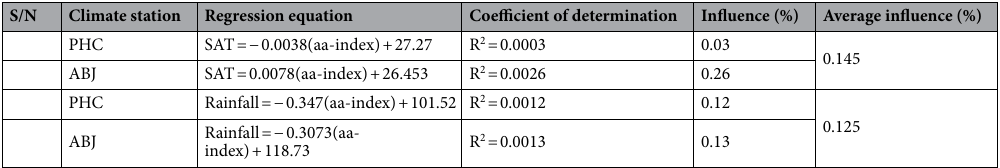
Table 4. Regression equations for geomagnetic aa-index regressed on SAT and Rainfall in Nigeria and Cote D’Ivoire during solar cycles 22–24.